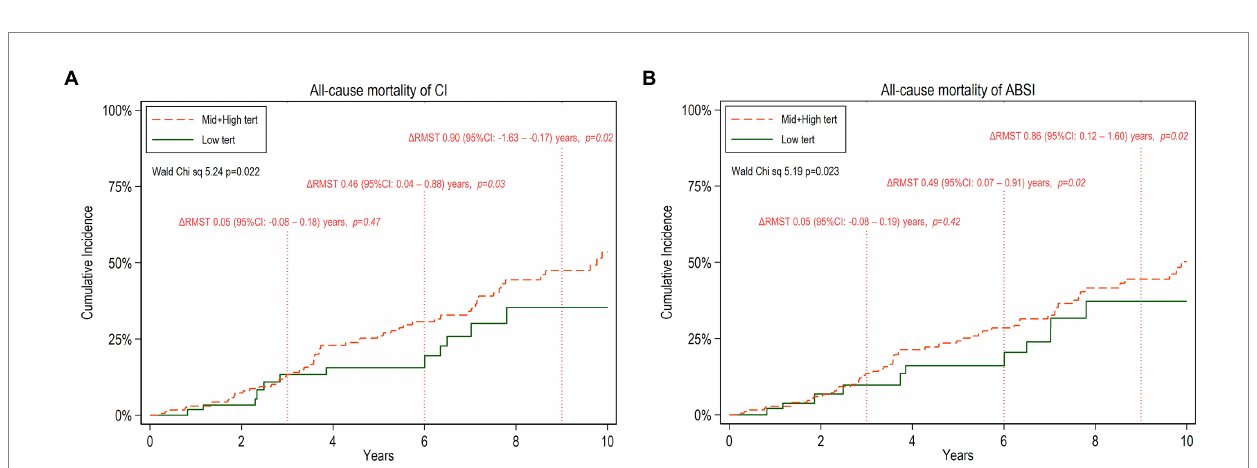
FIGURE 2 Cumulative incidence of all-cause mortality for 10 years follow-up of CKD5 patients with low versus high and middle tertiles of CI (A) and ABSI (B) respectively. The mean difference between the two tertile groups of restricted mean survival time truncated at 3, 6, and 9 years, Δ RMST with 95% confidence interval (95%CI), is